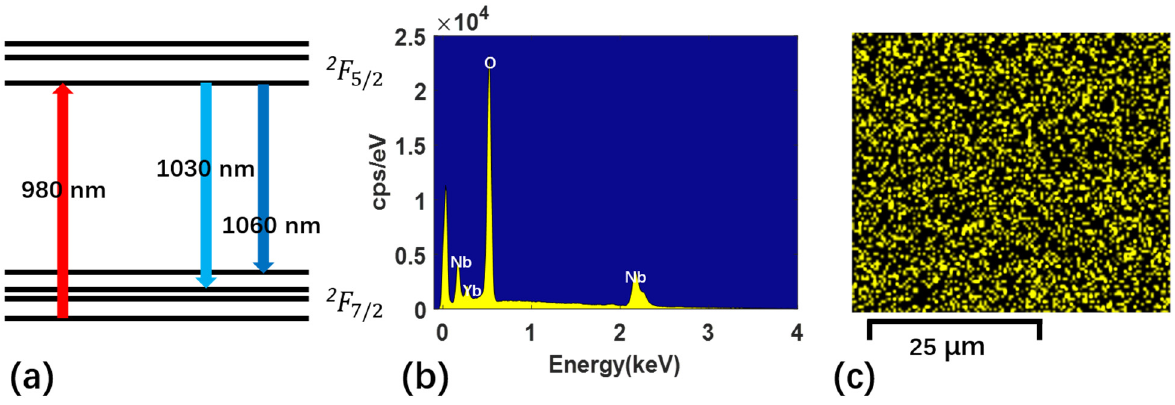
Figure 2. ( a ) The energy level diagram of Yb 3+ . ( b ) The in situ quantitative elements analysis of the fabricated YDWA measured by energy dispersive spectrometer (EDS). ( c ) The map of ytterbium element analysis in waveguide samples by of EDS.